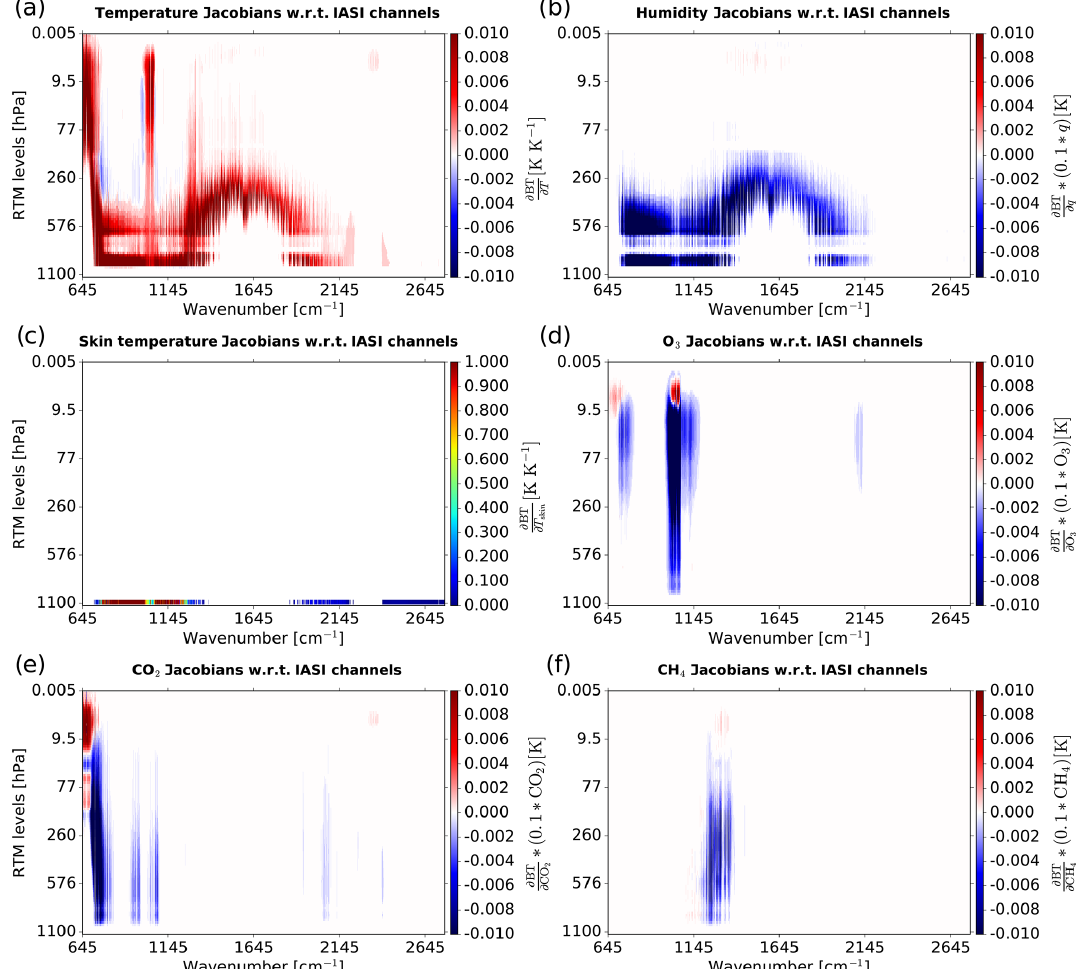
Figure 6. Jacobians of temperature (a) , humidity (b) , skin temperature (c) , ozone (d) , carbon dioxide (e) and methane (f) for 8461 IASI channels w.r.t. 101 RTM